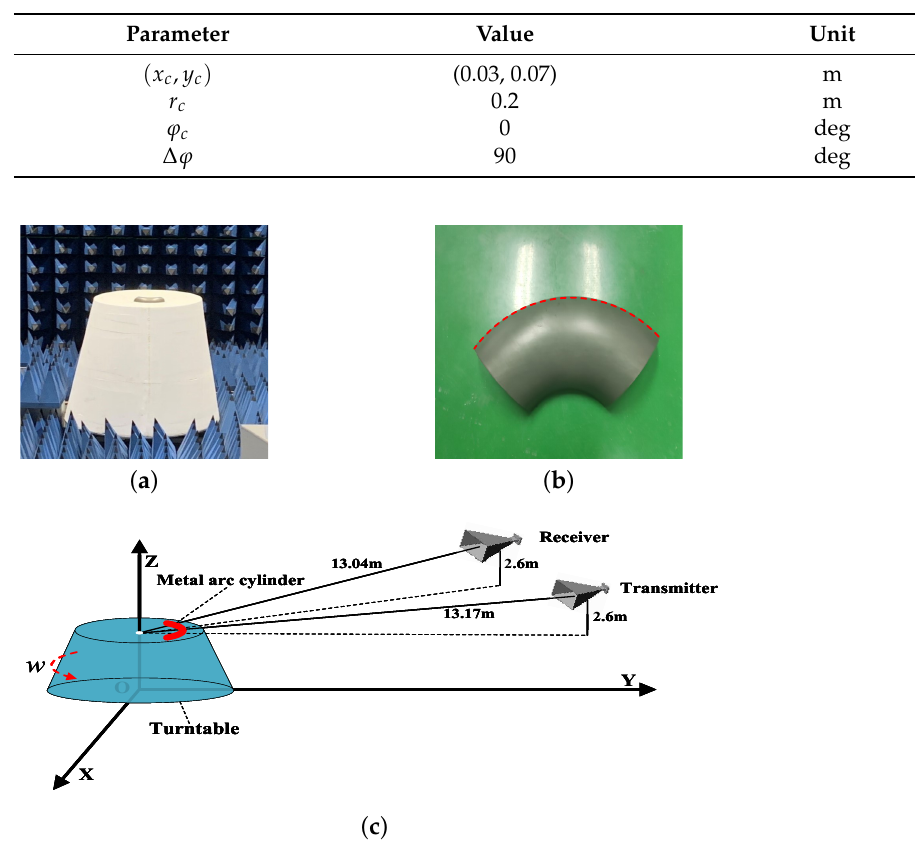
Table 5. Target parameters in Figure 14.